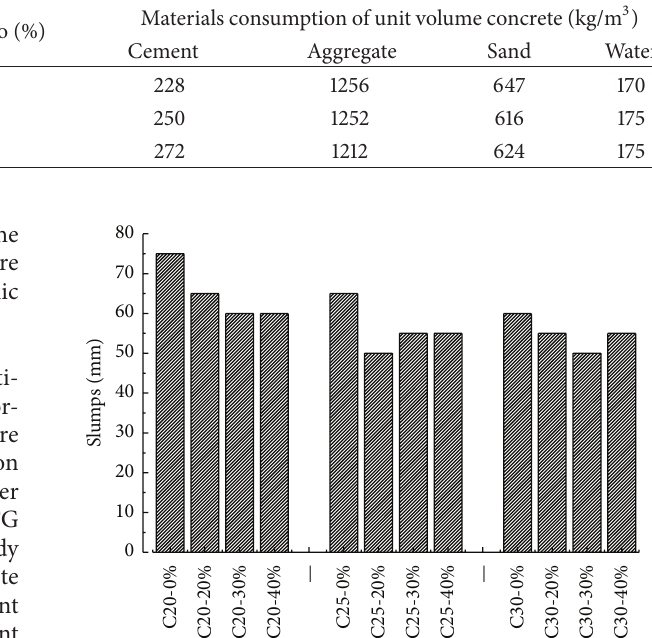
Table 5: Reference mix ratios of the C20, C25, and C30.